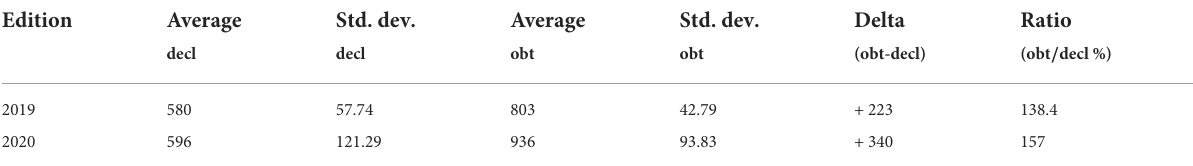
TABLE 4 Declared (decl) and obtained (obt) scores for teams in the two editions.